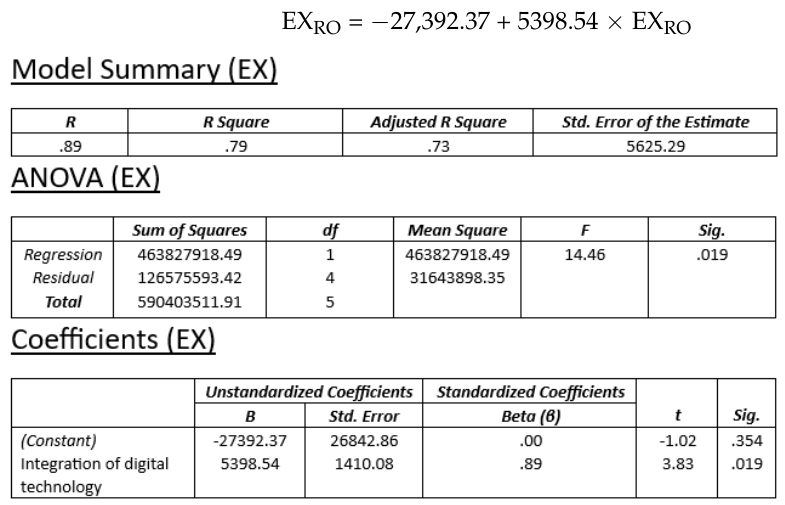
Figure 15. Linear regression: digitization and exports—Romania.